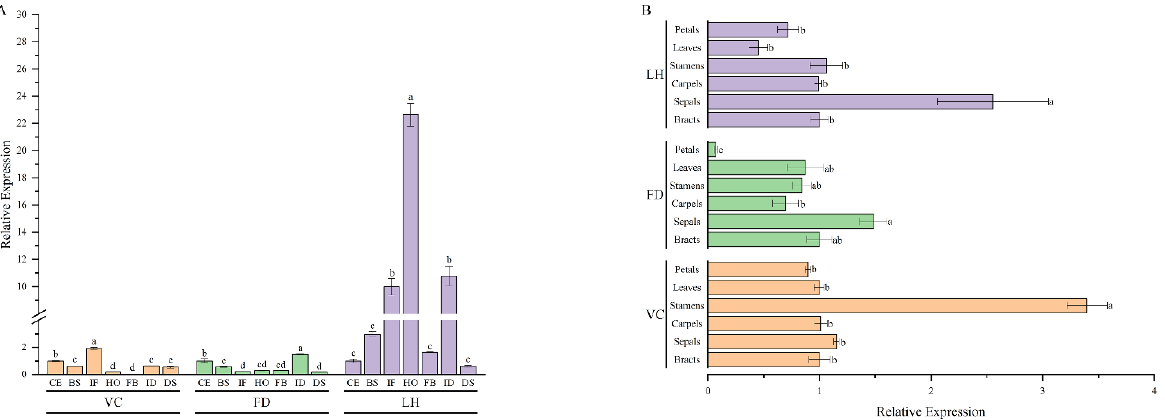
Figure 3. Expression patterns of PoVIN3 in tree peony. ( A ) The relative expression levels of PoVIN3 in different developmental stages. ( B ) The relative expression levels of PoVIN3 in different tissues. Error bars represent standard error (SE). Different lowercase letters indicate significant differences at p < 0.05.